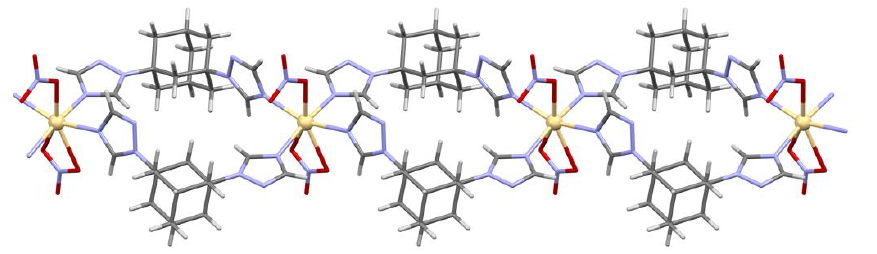
Figure 4. Chain of coordination polymer 2, viewed along c axis. Atom legend: Cd—yellow balls; C—dark gray dots; N—blue dots; O—red dots; H—white dots.